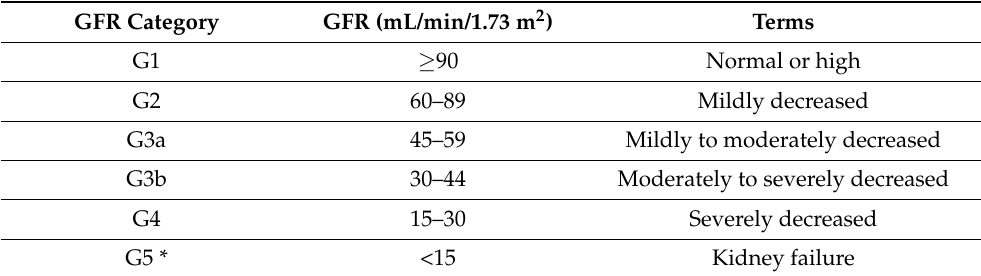
Table 1. GFR categories in